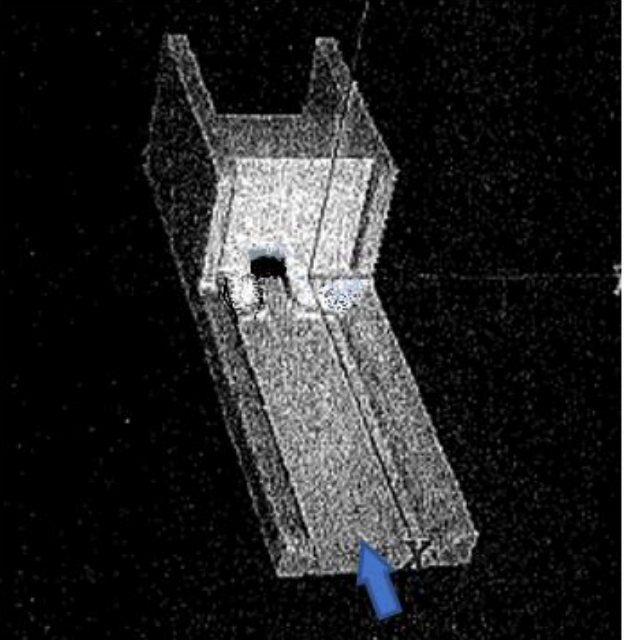
Figure 60. FLOW-3D CFD model of the deeply buried water transfer structure. Arrow denotes flow direction. Central opening is ~0.5 m by 0.5 m. Portions of back wall height were destroyed by later constructions. Note the dual ellipsoidal structures at base of wall, the leftmost one shown in Figure 61. Figure derived from [1], p. 332.